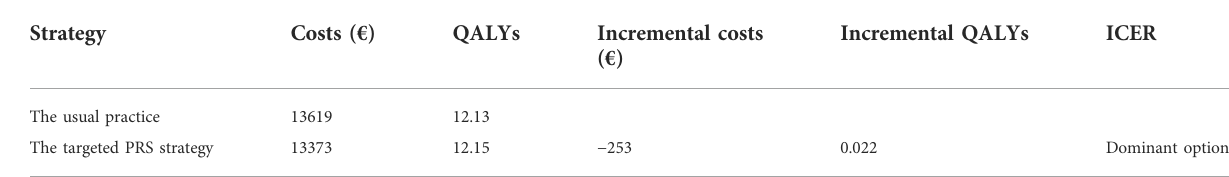
TABLE 4 Base-case results.